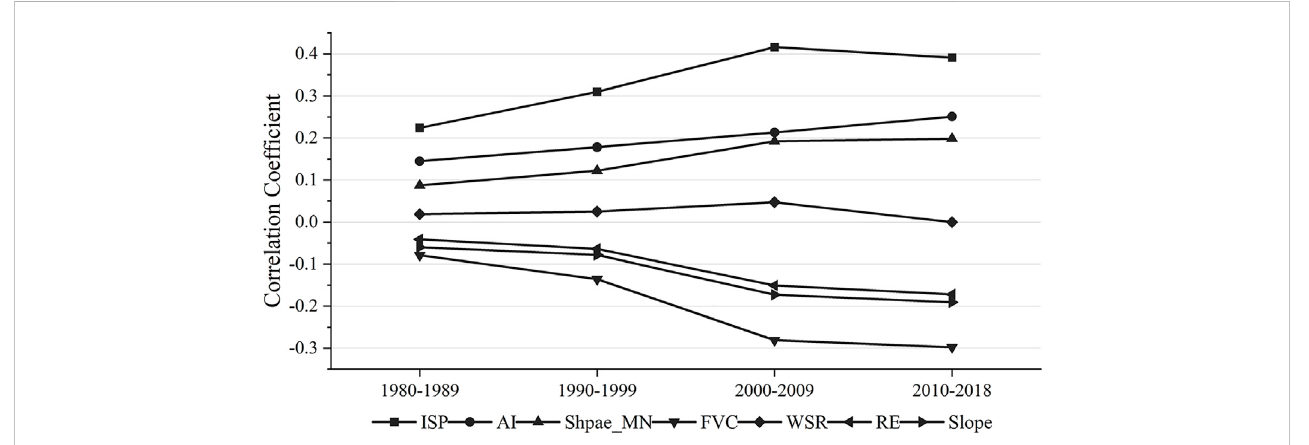
FIGURE 3 Correlation coef fi cient change of each in fl uence factor of urban fl ooding in the GBA.